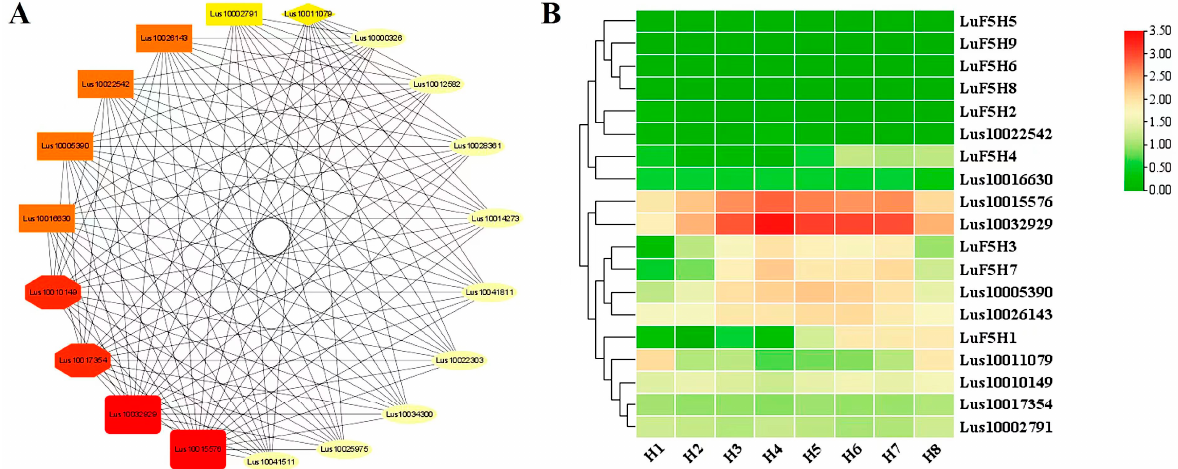
Figure 7. PPI networks of F5H proteins and interacting protein expression patterns in flax. ( A ) PPI networks of F5H proteins in flax. Different shapes represent different functions of proteins. The ellipse is the LuF5H protein to be studied, and the colors from yellow to red indicate a greater proportion of this protein in the PPI network. ( B ) Interacting protein expression patterns. The periods represented by H1–H8 are shown in Figure 5. Red represents a high expression level, and green represents a low expression level.